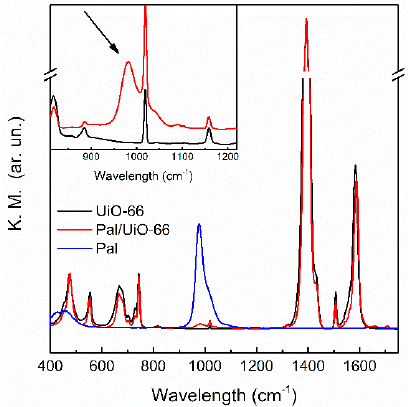
Figure 3. Attenuated total reflectance Fourier infrared spectroscopy (ATR-FTIR) spectra of Pal, UiO-66, and composite containing palygorskite